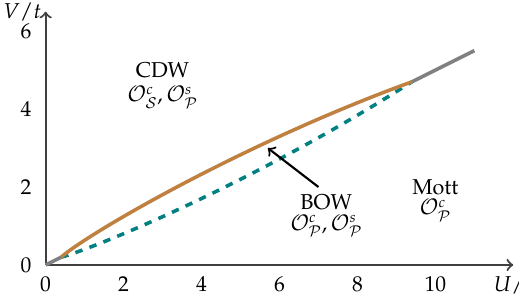
Figure 3. Phase diagram of the extended Hubbard